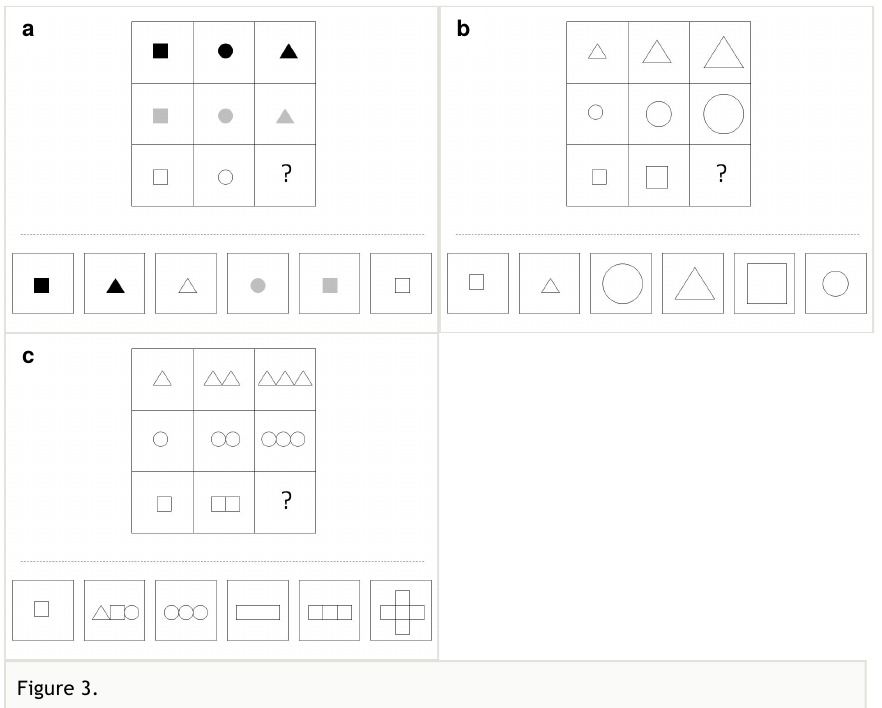
Figure 3. Examples of “Integration of modi fi ers” questions. a : Integration of color modi fi er. The top two rows of the matrix indicate the rule: “the object in the right column is the result of combining color indicated in the row and the object indicated in the column” (solution: the white triangle in the tird cell). b : Integration of size modi fi er. The top two rows of the matrix indicate the rule: “the object in the right column is the result of combining size indicated in the column and the object indicated in the row” (solution: the square in the fi fth cell). c : Integration of number modi fi er. The top two rows of the matrix indicate the rule: “the